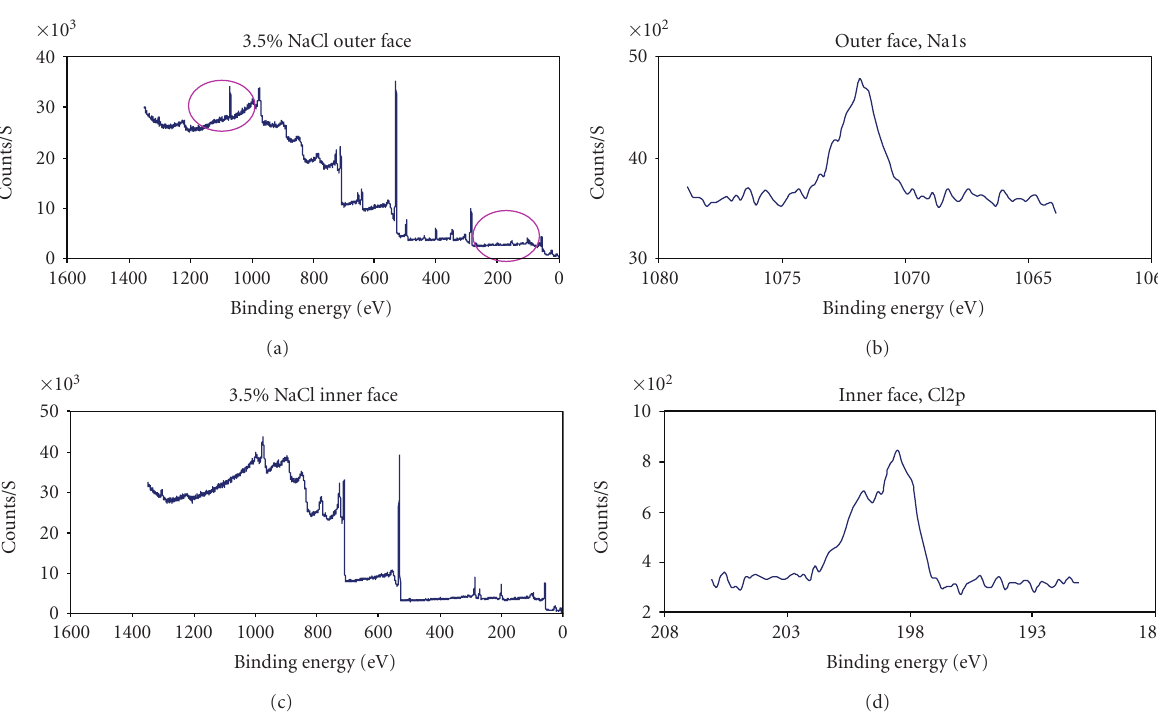
Figure 14: XPS spectra of a specimen exposed in aerated solution of 3.5%